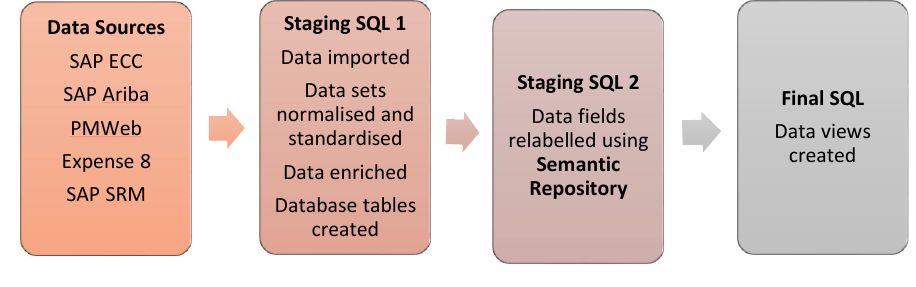
Figure 3. SQL Semantic